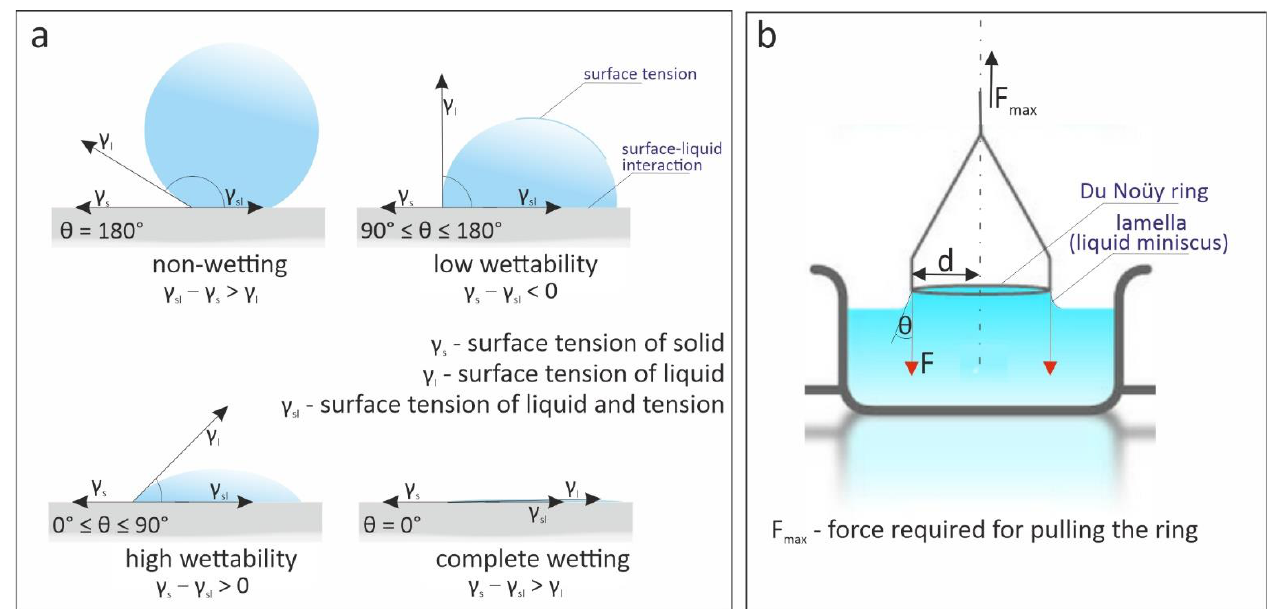
Figure 1. Surface – liquid interaction at the surface tension in ( a ) the contact angle method, and ( b ) the Du Noüy method.